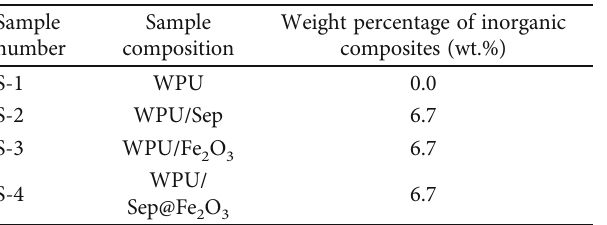
Figure 1: Schematic of WPU composite preparation. Table 1: Sample number of fi lm samples.